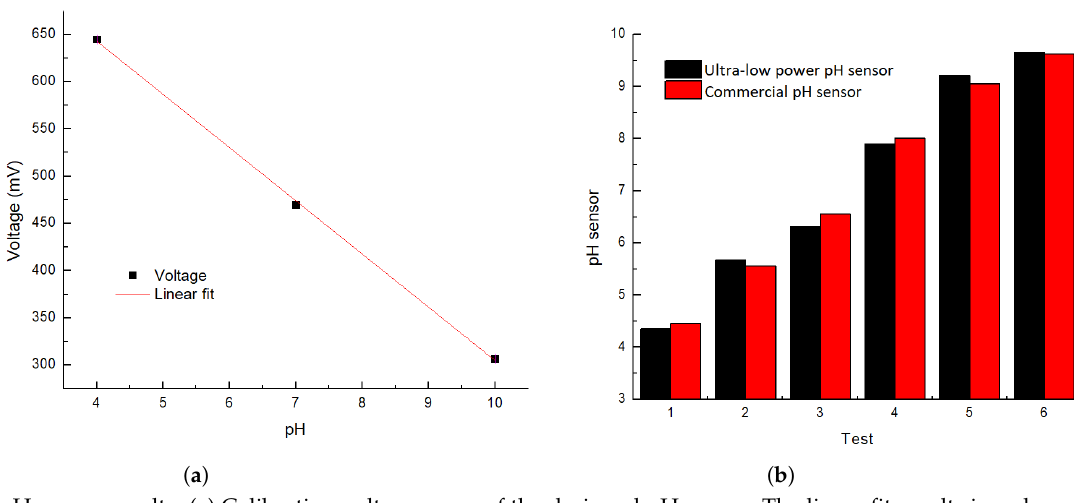
Figure 11. pH sensor results. ( a ) Calibration voltage curve of the designed pH sensor. The linear fit results in a slope of − 56.33 mV/pH at 25 ◦ C. and ( b ) Comparison between the ultra-low power pH sensor and commercial pH sensor.